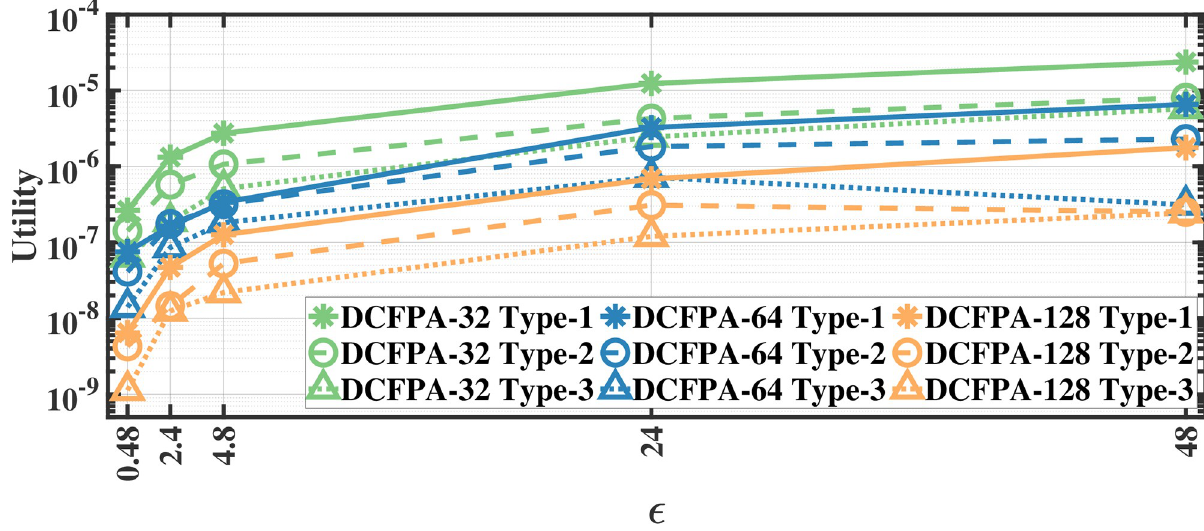
Fig 9. Utility of the DCFPA for MPIIDPEye.